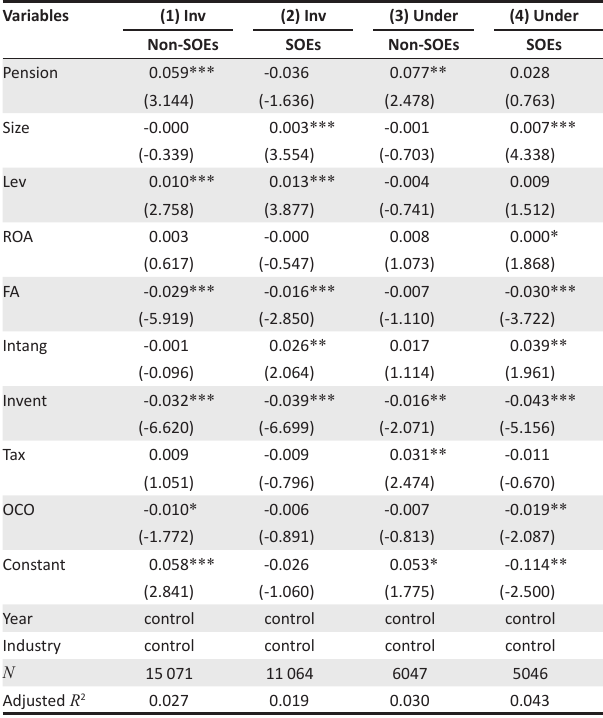
TABLE 8: Investment cashflow sensitivity–adjusted test. TABLE 9: Ownership structure-adjusted